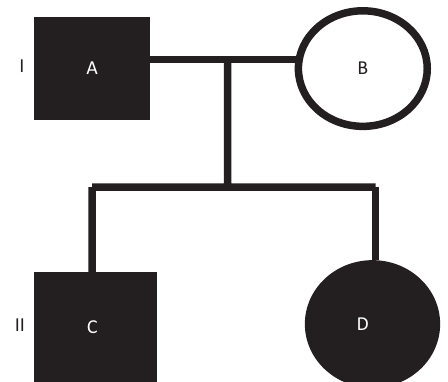
Figure 1. The family pedigree of the patient. (A) The pa- tient’s father is a 65-year-old VHL patient. (B) The patient’s mother is a 64-year-old non-VHL woman with malignant lymphoma and colon cancer. (C) The patient’s brother is a 39-year-old VHL patient. (D) The current VHL patient is a 36-year-old woman with an optic nerve